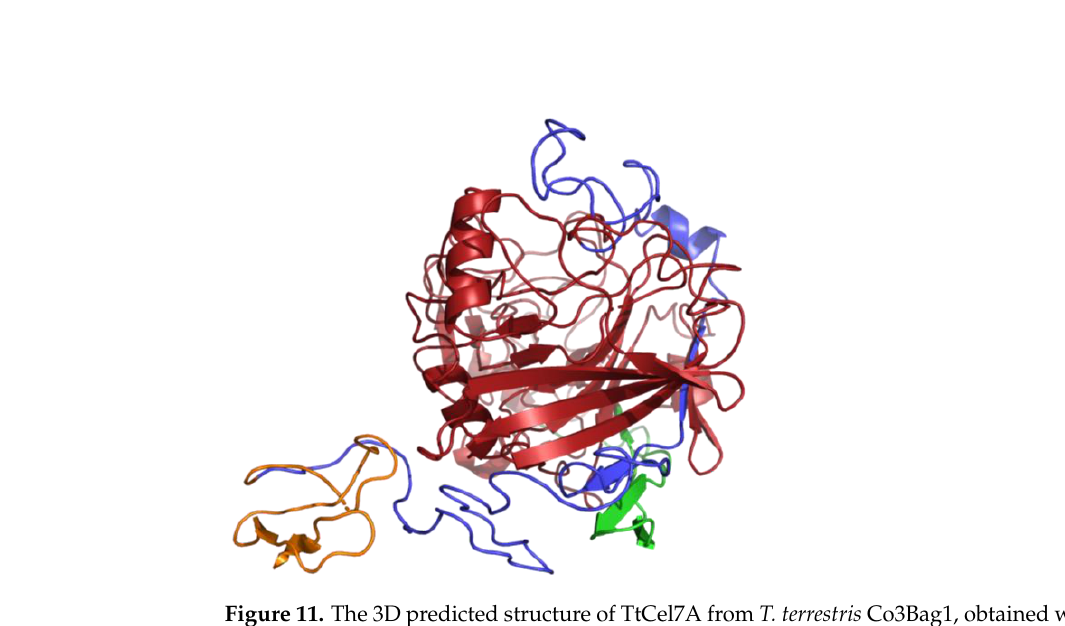
Figure 11. The 3D predicted structure of TtCel7A from T. terrestris Co3Bag1, obtained with the Phyre 2 server. The CD was identified with red, the CBM with orange, and the linker region with blue color.